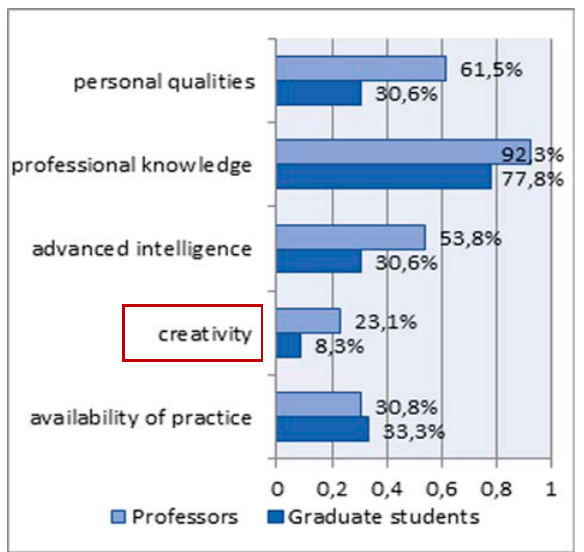
Fig. 5. Image of a graduate of MSTU Stankin from the point of view of